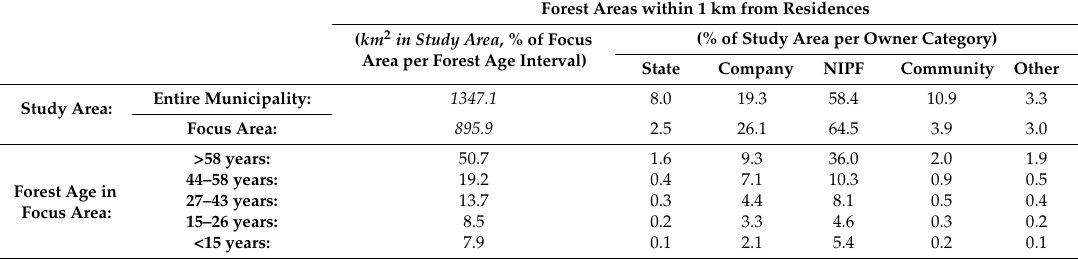
Table 3. Areas within 1 km from residences per forest owner category in Vilhelmina municipality (Sweden) and in our focus study area. Land ownership is categorized in State, Company (large-scale forest companies), NIPF resident and NIPF non-resident (non-industrial private forest owners identified as living in or outside the municipality) and NIPF mix (a mix of NIPF resident and NIPF non-resident owners), Community (a large forest common, the municipality, and some smaller village commons), and Other (the church, foundations, and unidentified